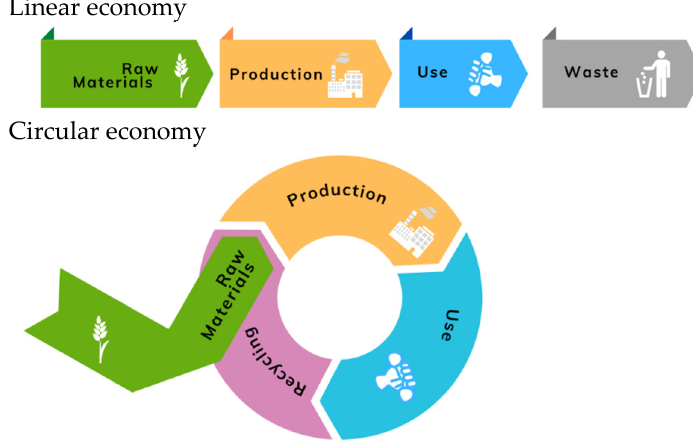
Figure 5. Linear and circular economy models.